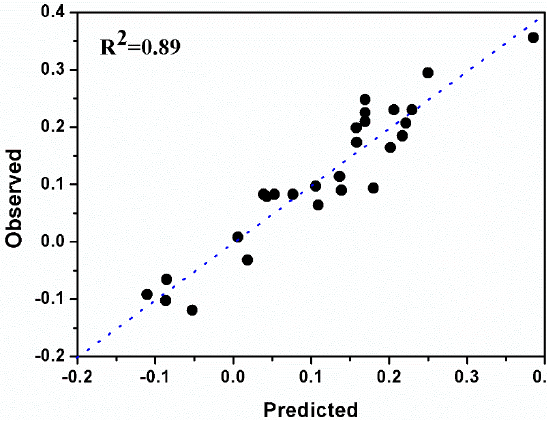
Figure 2. The observed versus predicted values of the diameters.